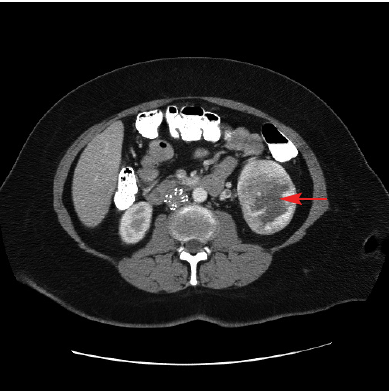
Figure 4. Renal cell carcinoma, clear cell type. Microscopic examination of the kid- ney tumor shows alveolar architecture of the cells with clear cytoplasm and distinct cell boundaries in a background of delicate vasculature. (H&E stain; magnification